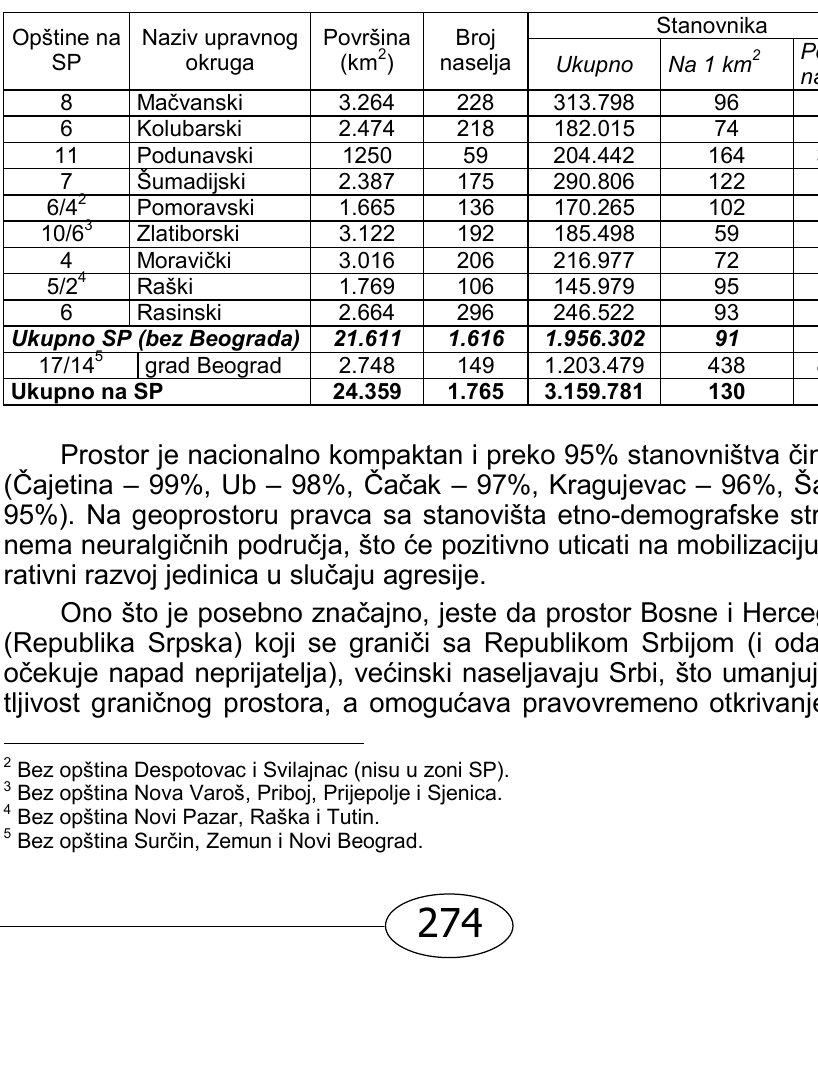
Pregled stanovništva i naselja na strategijskom pravcu (po okruzima) Summary of the population and settlements on the strategic direction (by districts) Opštine na